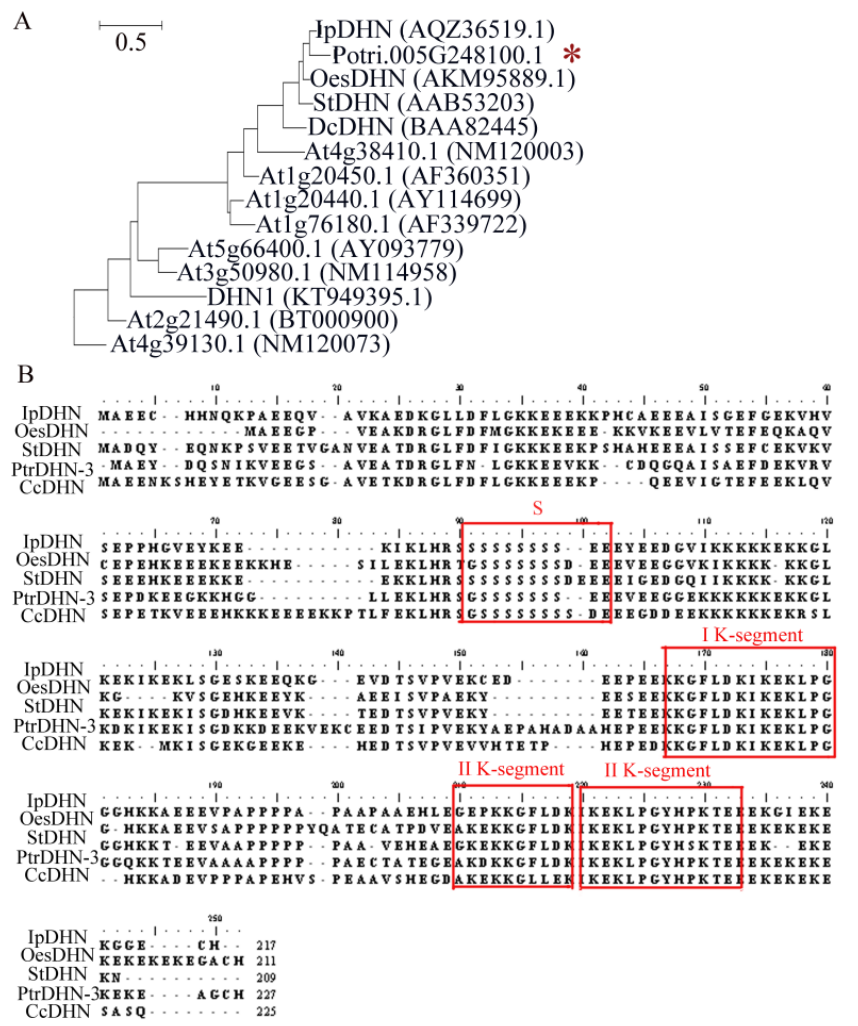
Figure 1. ( A ) Phylogenetic relationships between the PtrDHN-3 (Potri.005G248100.1) protein and dehydrins (DHNs) from other plant species. The molecular phylogeny was constructed from complete protein sequence alignment using the neighbor-joining method with ClustalW. The scale bar indicates the average number of amino acid substitutions per site. “*” Indicates the position of PtrDHN-3 in the phylogenetic tree. ( B ) Sequence analysis of the PtrDHN-3 protein. Multiple sequence alignment of the PtrDHN-3 protein with IpDHN ( Ipomoea pes-caprae L. AQZ36519.1), OesDHN ( Olea europaea L. subsp. europaea, var. Sylvestris, AKM95889.1), StDHN ( Solanum tuberosum L. AAB53203), CcDHN (Coffea canephora Pierre ex Forehn. ABC68275) and DcDHN ( Daucus carota L. BAA82445). Red squares indicate conserved amino acid sequences of S-and K-segment motifs. K segments include IK segment: EKKGIMDIKEKLPG and IIK segment: (Q/E)K(P/A)G(M/L)LDKIK(A/Q)(K/M)(I/L)PG